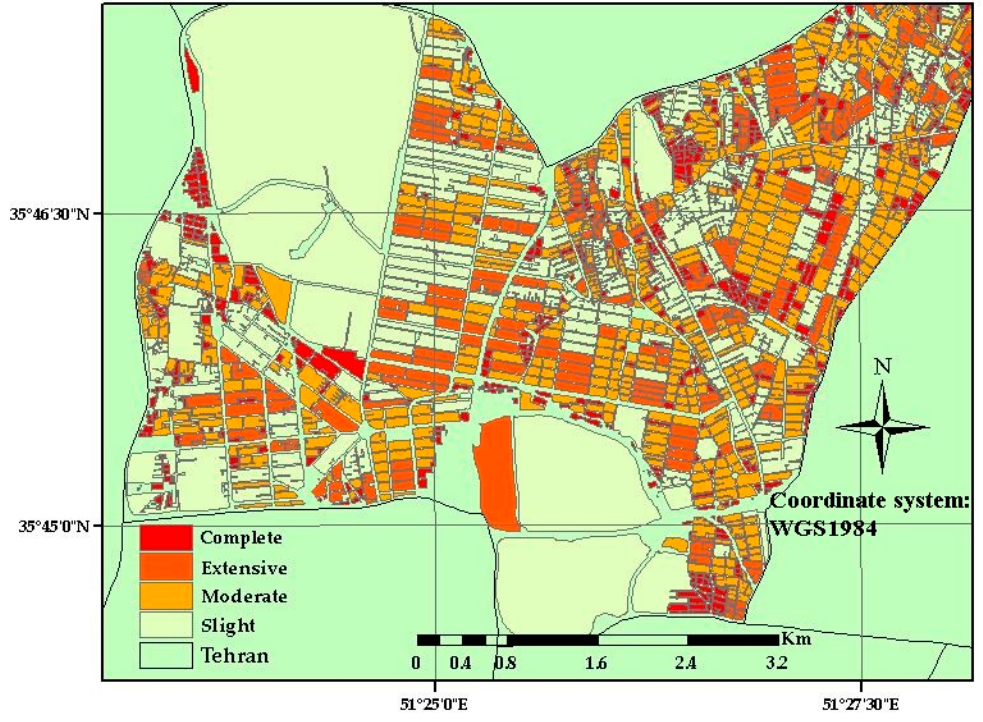
Figure 4. Four structural vulnerability levels in District 3, Tehran.